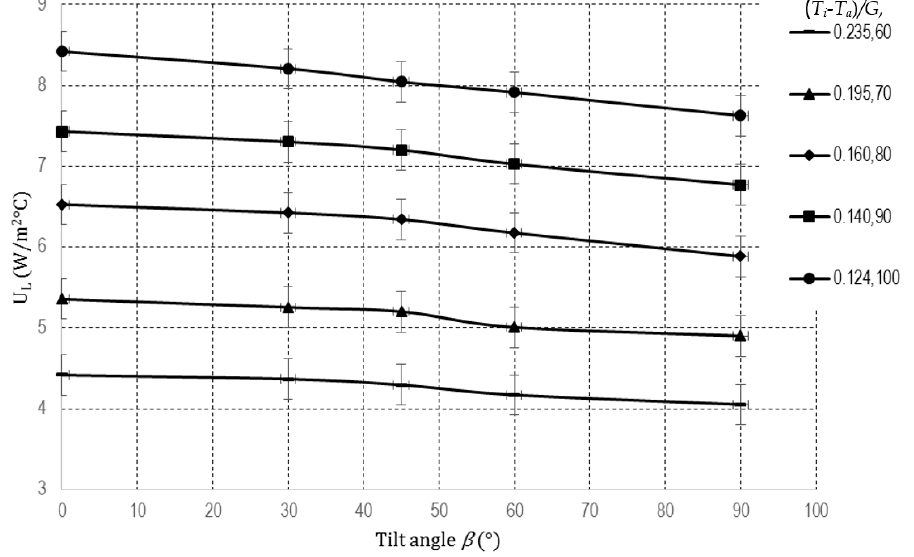
Figure 5. U L vs. β , for variable ( T i − T a )/ G at its corresponding T p , at Q u ( β ) = 0.